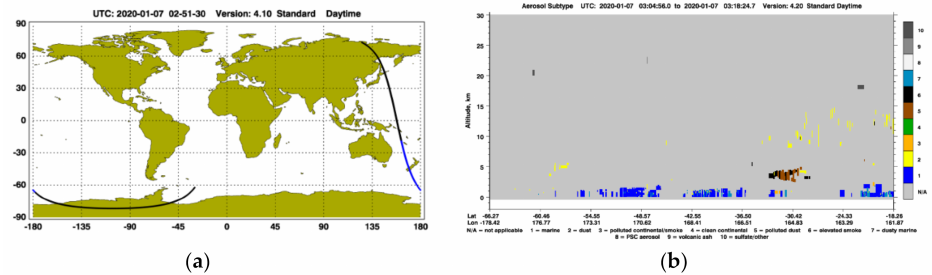
Figure A2. CALIPSO satellite path ( a ) and aerosol profile ( b ) over the Coral Sea and New Zealand on 7 January 2020 at 2:51 UTC. Smoke aerosols (black) over the Tasman Sea in the troposphere at the height of ~3 km to ~5